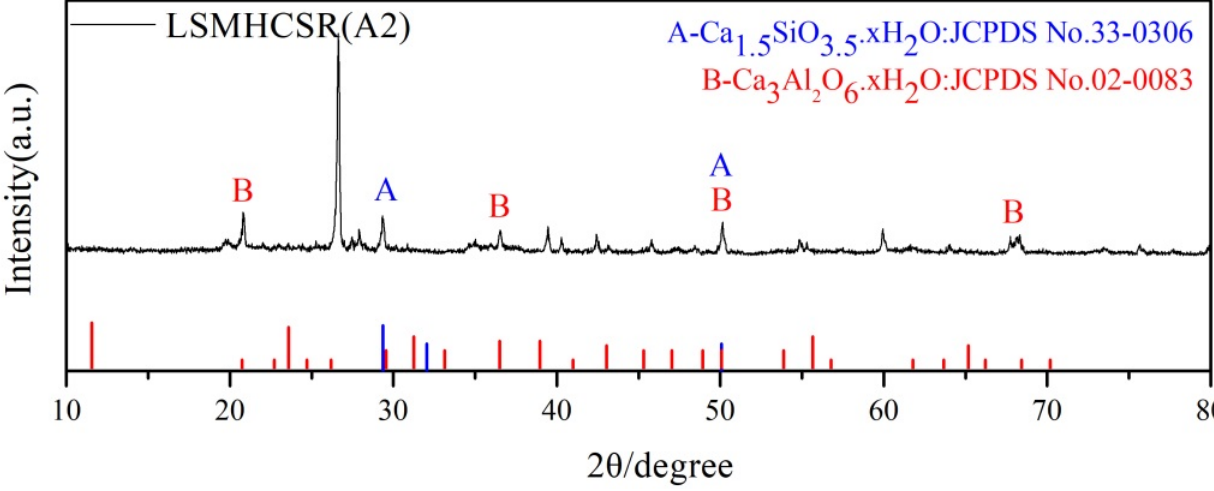
Figure 9. XRD spectra of A2.